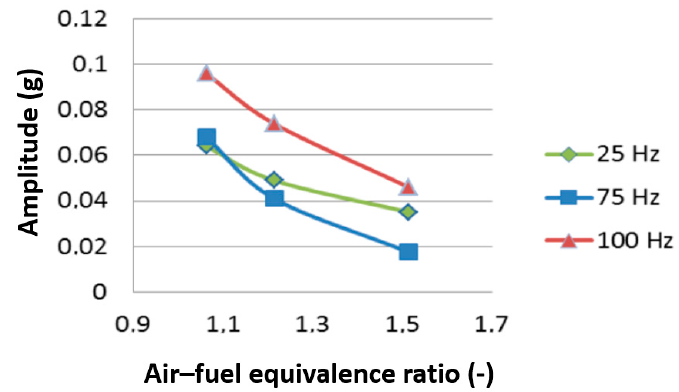
Figure 5. Amplitude changes of some frequency component as a function of ER [23]. Figure is reprinted with permission from publisher.